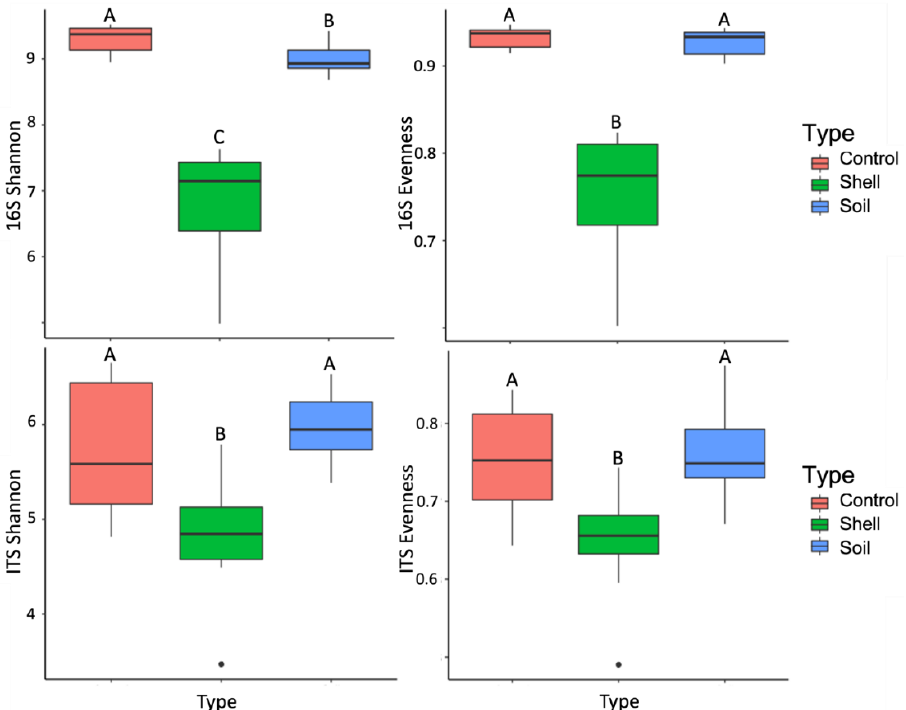
Figure 2. Estimated Shannon diversity and Evenness of bacterial and fungal communities. For each variable, data followed by different letters are significantly different according to Kruskal-Wallis pairwise test ( p < 0.05).